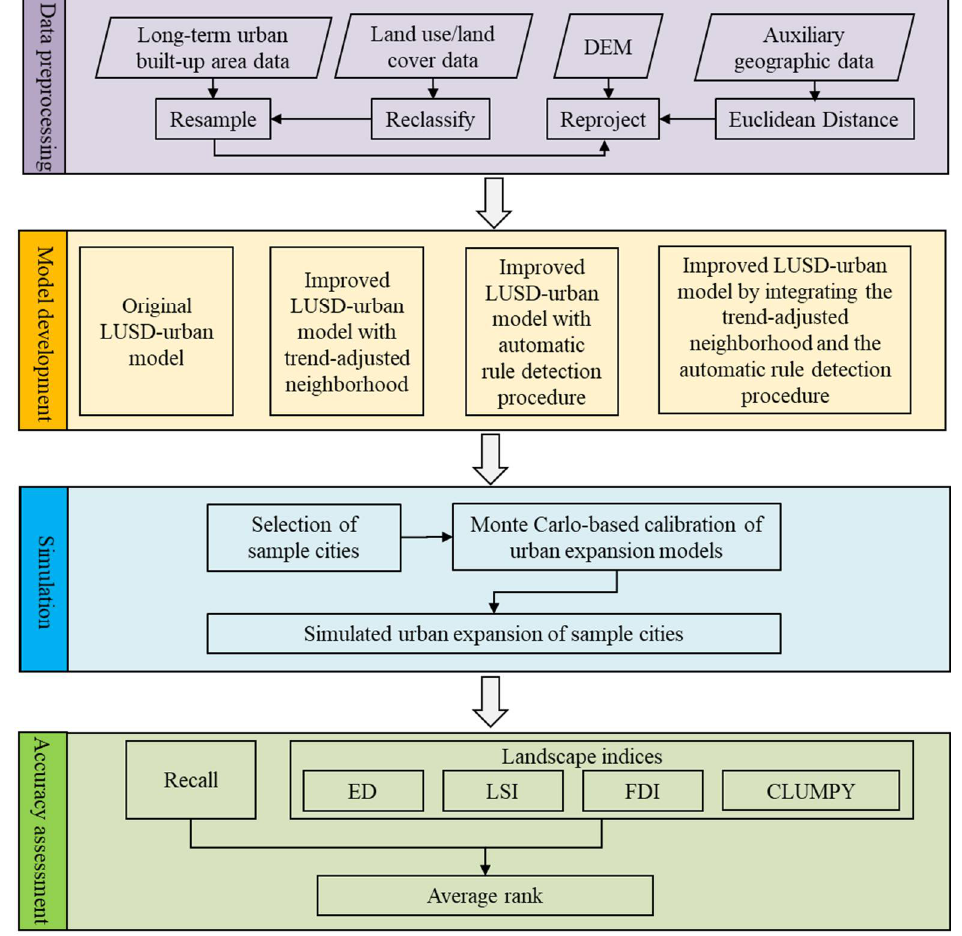
Figure 1. Flow chart.